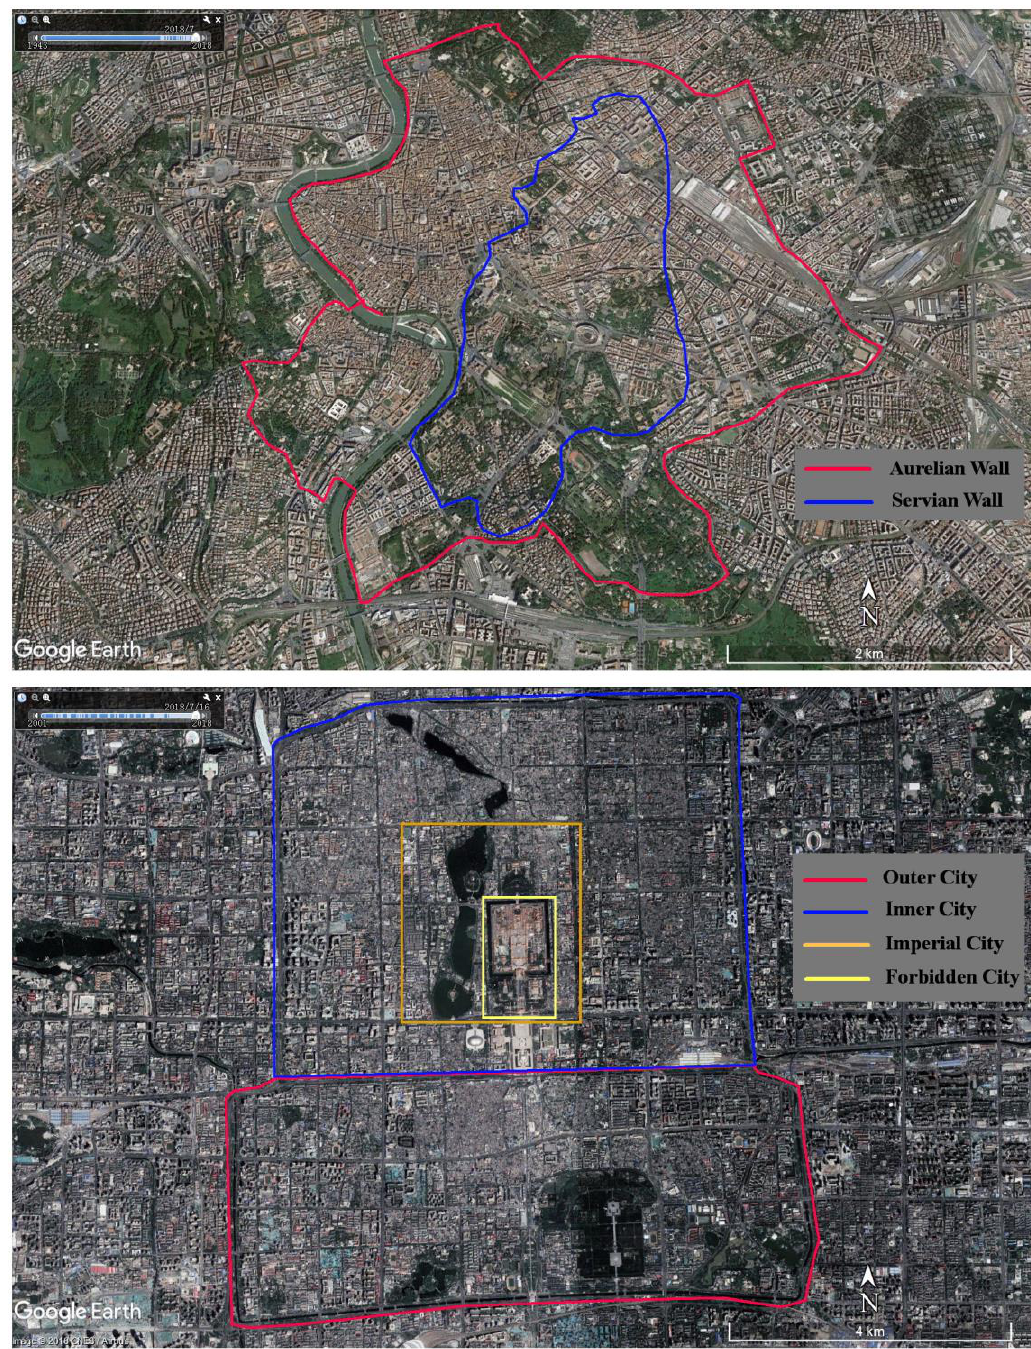
Figure 8. GE Historical image view of the Rome Historic Centre ( top ) and Old Peking ( bottom ) obtained using the “historical time slider”. Imagery © 2018 Digital Globe.